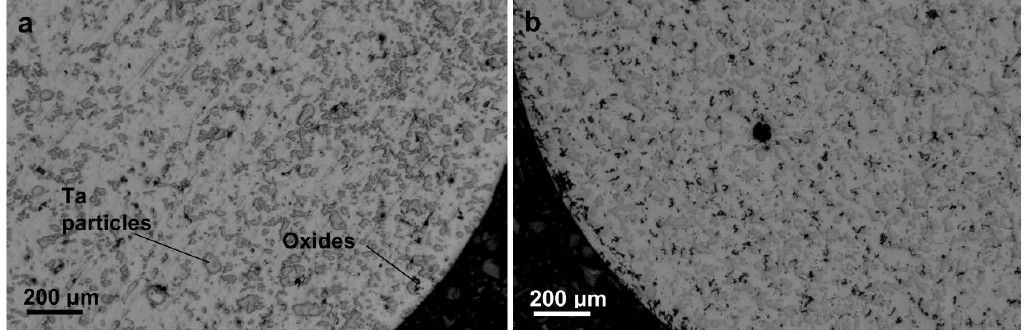
Figure 4. Optical micrographs of (La ( b ) rod 2. The black particles are La oxides, and they are more numerous in rod 2 specimens.